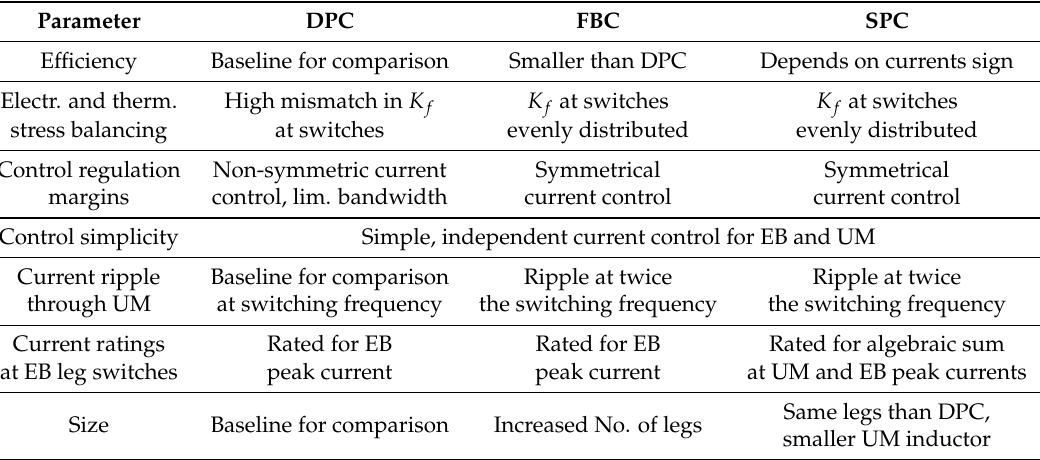
Table 6. Configuration